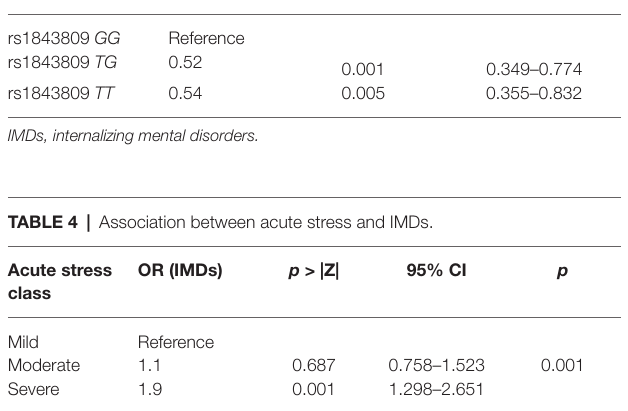
TABLE 2 | Distribution of genotypes and Hardy-Weinberg equilibrium analysis between cases and controls for SLC6A4 [ 5-HTTLPR , rs25531, 5-HTTLPR - rs25531, and STin2 VNTR] and TPH2 [rs1843809, rs1386494, rs34517220, and rs4570625]